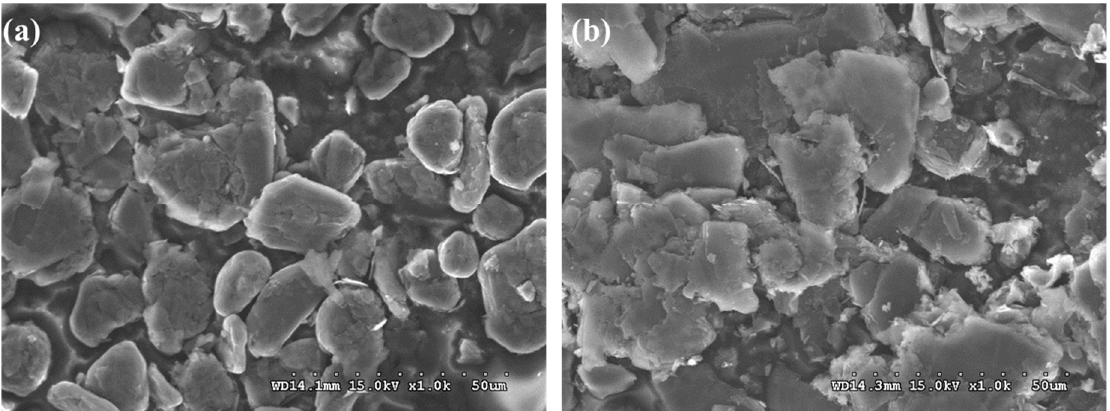
Figure 7. X-ray diffraction patterns of pristine and post-cycled natural graphite electrodes.